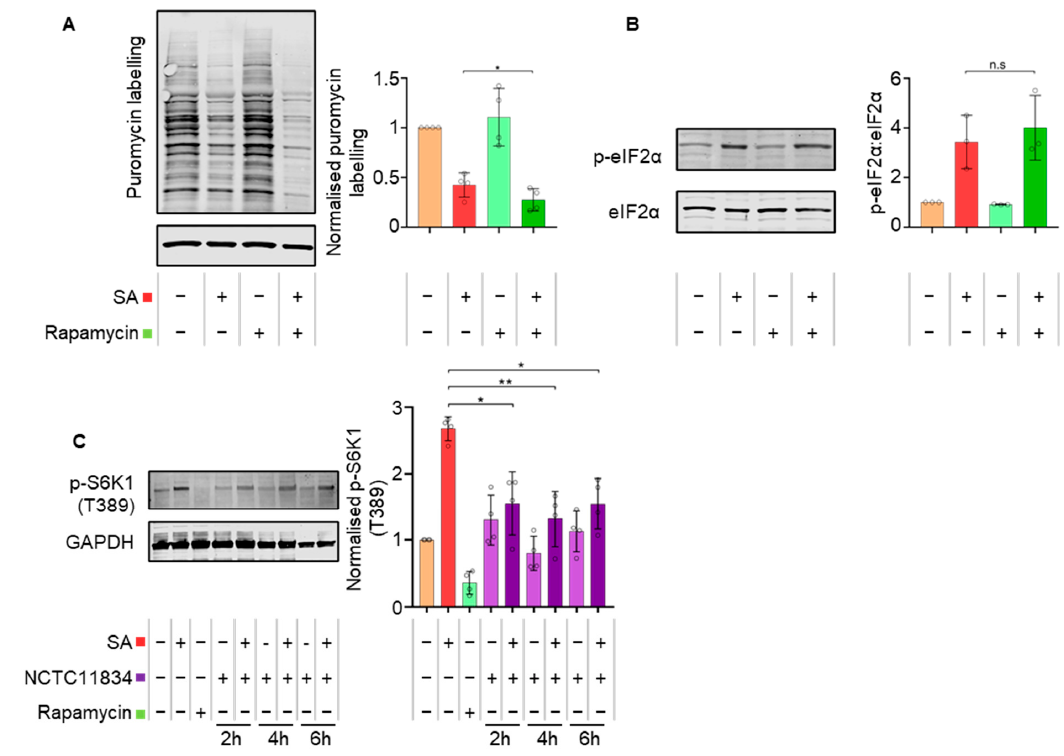
Figure 5. Rapamycin treatments exert the same effect on translation during oxidative stress as P. gingivalis and P. gingivalis attenuates stress-induced p-p70-S6-Kinase (T389). ( A ) Relative rate of protein synthesis as measured by puromycin uptake (left) and relative concentration compared to GAPDH in H357 cells treated with rapamycin and sodium arsenite as determined by immunoblotting (right). ( B ) Levels of phosphorylated eIF2 α (left) and ratio of phosphorylated to total eIF2 α as determined by immunoblotting (right) (mean ± SD, n = 3). ( C ) Levels of p-p70-S6K1 (T389) (left) and p-p70-S6K1 (T389) concentration relative to GAPDH in cells treated with P. gingivalis (NCTC11834, MOI of 100, t = 2–6 h) with and without sodium arsenite as determined by immunoblotting (right) (mean ± SD, n = 4). **, p ≤ 0.01; *, p ≤ 0.05 according to Kruskal–Wallis with Conover–Inman